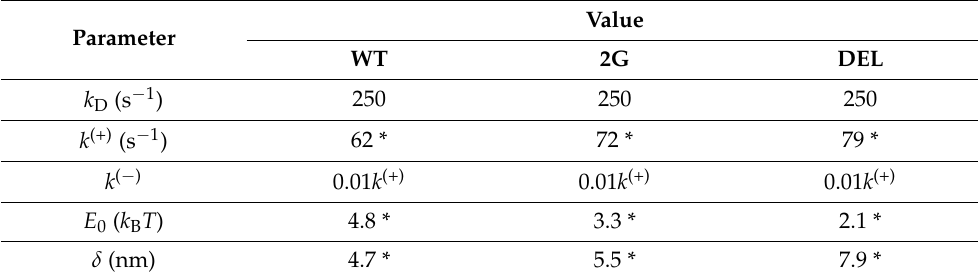
Table 1. Parameter values for Drosophila melanogaster kinesin-1 motors.